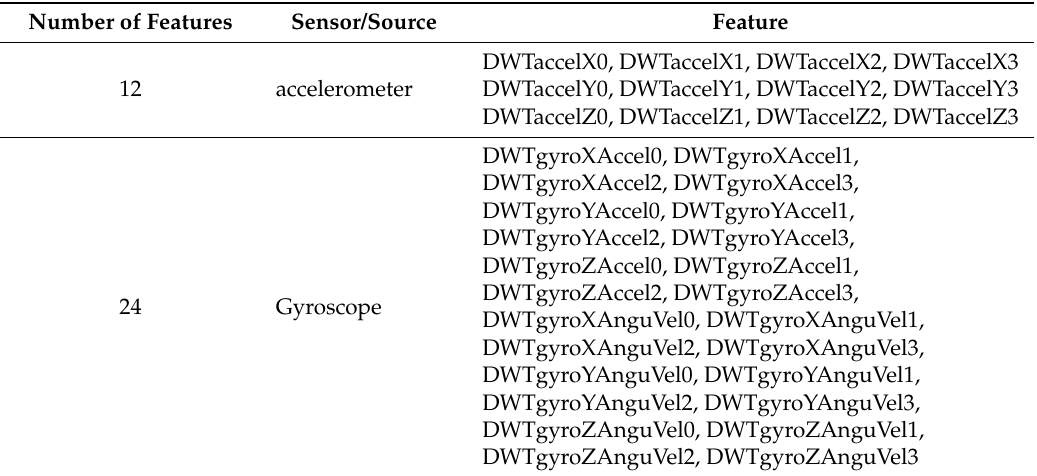
Table 2. Wavelet features for data